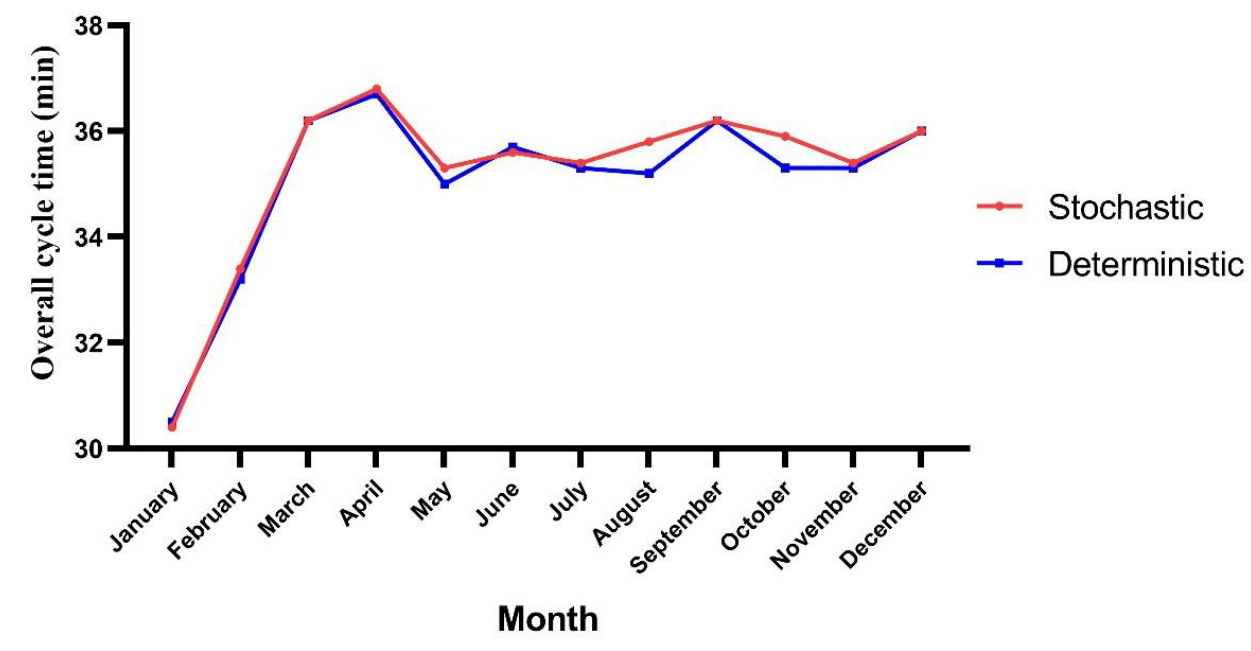
Figure 12. Overall cycle time in the stochastic and deterministic models.